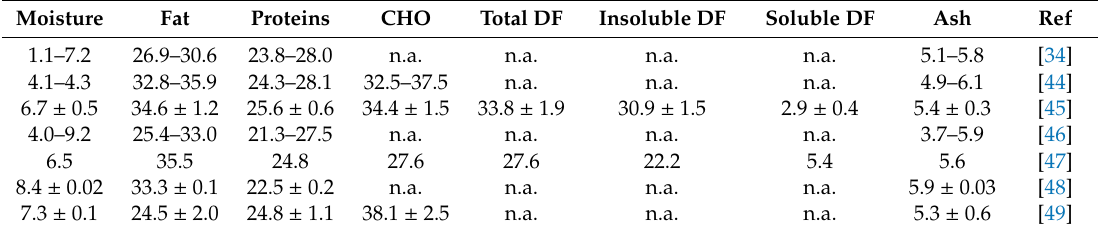
Table 2. Hempseed nutritional characteristics (mg / 100